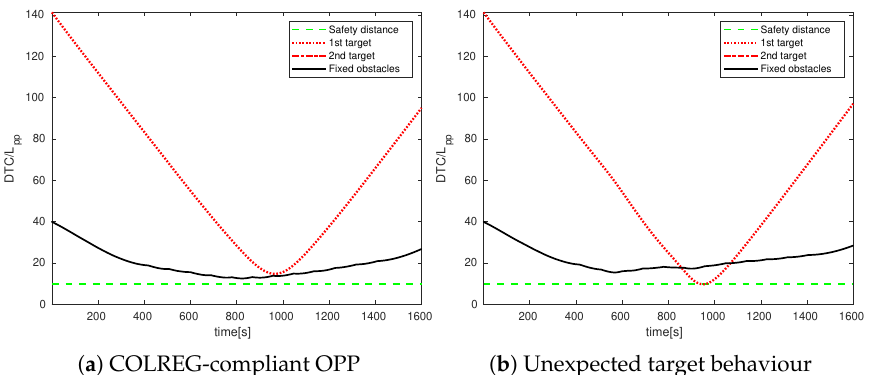
Figure 19. Scenario 3: DTC during simulation of a COLREG-compliant manoeuvre (Figure 16a) and COLREG-compliant manoeuvre with unexpected target behaviour (Figure